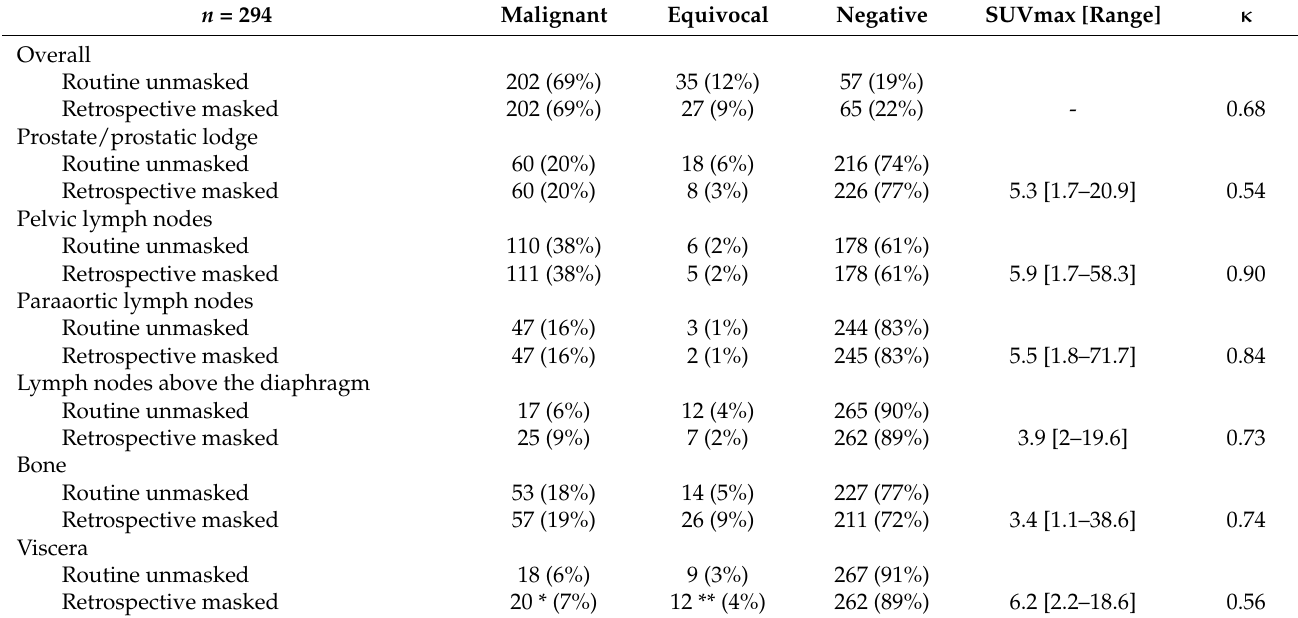
Table 2. [ 68 Ga]Ga-PSMA-11 PET/CT positivity rates in prostate cancer patients investigated due to a biochemical recurrence (irrespective of total prostate-specific antigen serum values). Results of routine unmasked and retrospective masked readings, both by anatomical site and overall, are presented. Median maximum standard uptake values (SUVmax) per anatomical site are presented with their range brackets. Agreement was evaluated with Cohen’s kappa coefficient κ